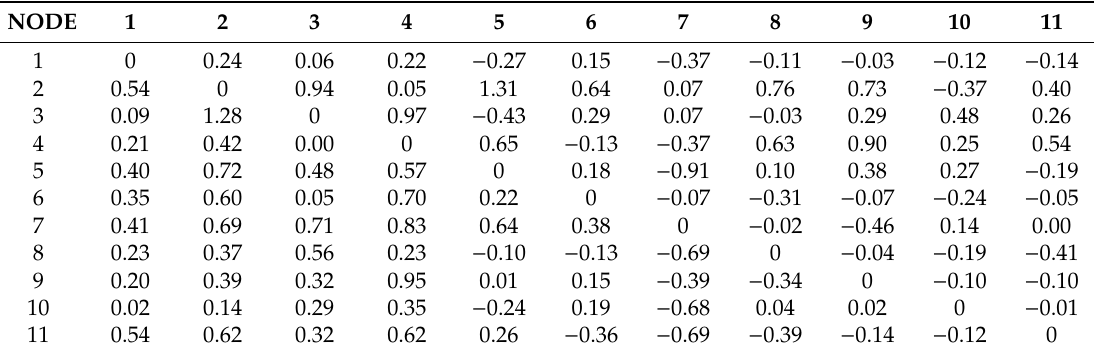
Table A5. Real Madrid’s individual Relative Out-Transition Entropy